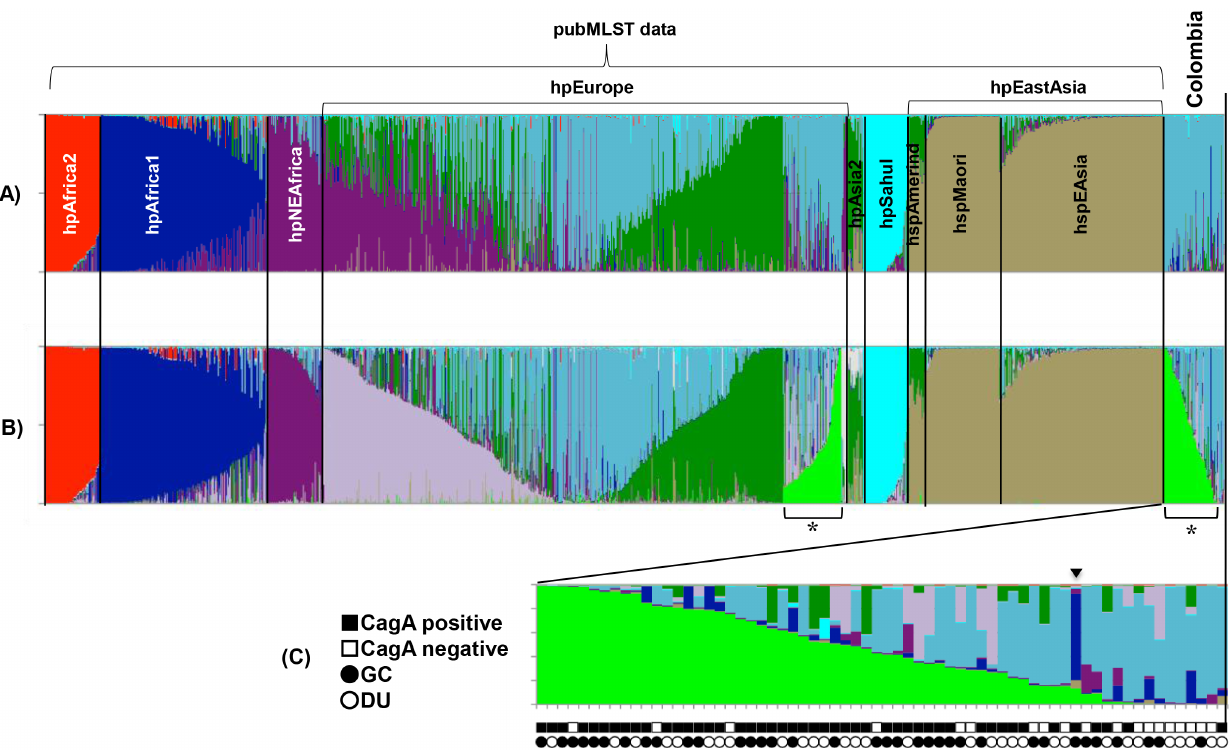
Figure 4. Population structure of Colombian strains. Results of population analysis by STRUCTURE (A) with K, or a tentative number of population, set to 7, (B) with K=10, (C) magnified chart of Colombian strains. Each vertical bar represents one sample. Colors indicate population components and the lengths of the colors in a vertical bar are proportional to the probability that the sample belongs to the population of the color. The order of the samples is the same in all the bar charts. The stars in panel B represent Colombian strains and hpEurope strains that share the same population component. cagA types and diseases of Colombian strains are shown by marks below the bar chart (C).